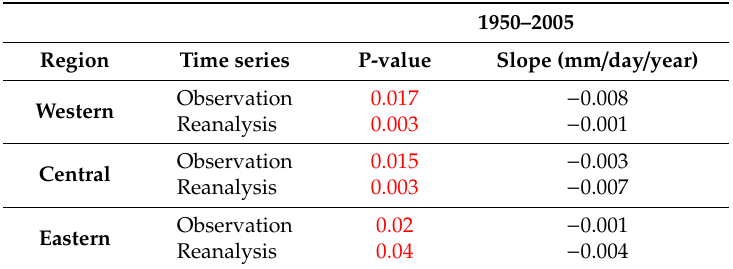
Table 4. Results of modified Mann–Kendall test for precipitation trend detection for observations and reanalysis over 1950–2005 in three parts of North Africa. Significant test results ( p -value ≤ 0.05) shown in